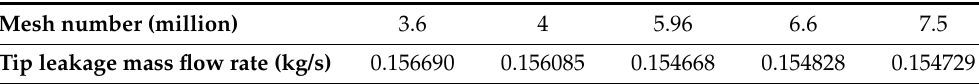
Table 2. Validation of grid independence.